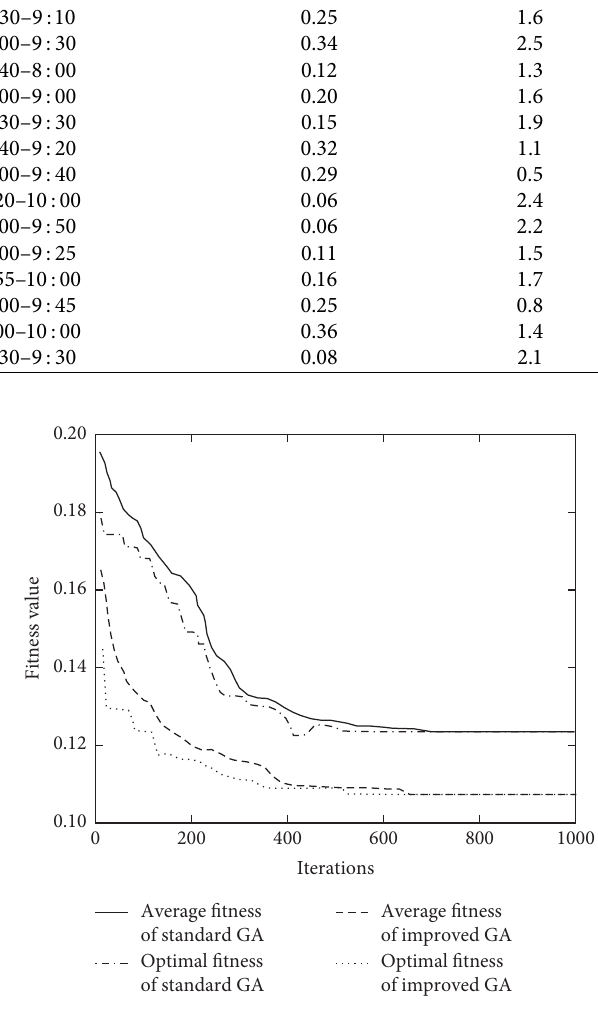
Figure 6: Optimization iteration curve of total objective function.